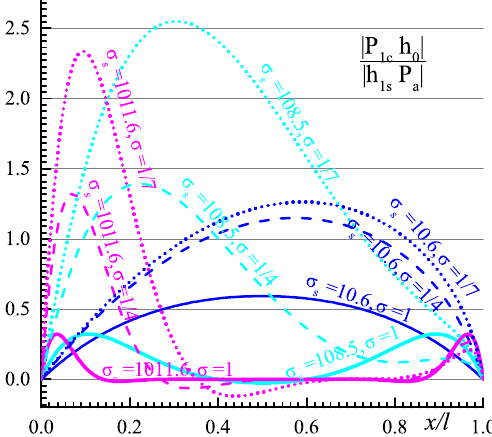
Figure 11. Distribution of P 1c inside of 1D parallel slider with high-pressure in the